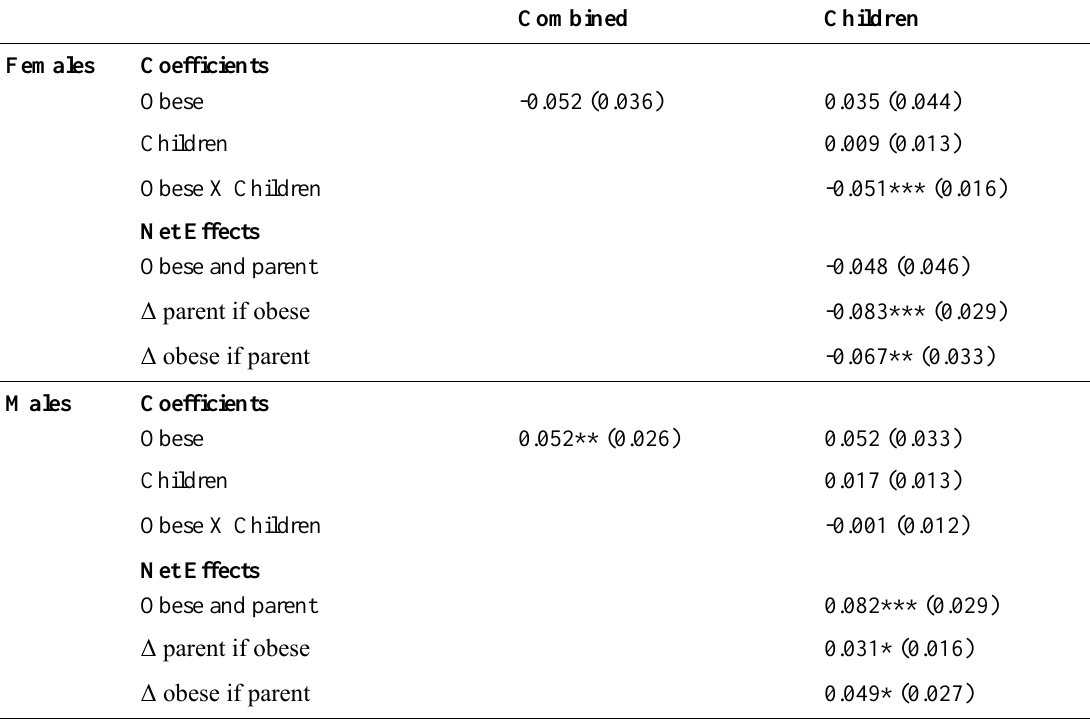
Estimated wage effects of